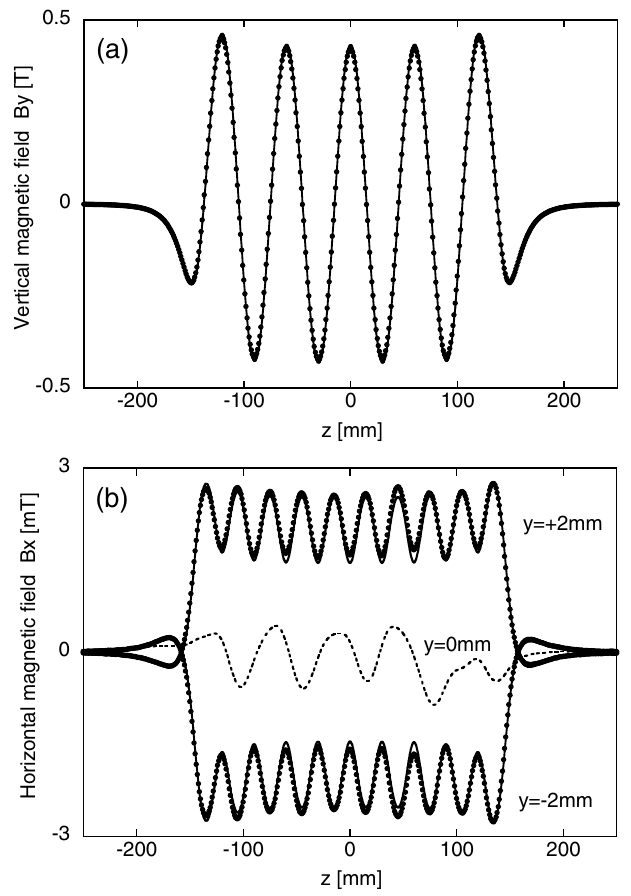
FIG. 5. Magnetic field of the EF wiggler at a magnet gap of 30 mm measured along the beam axis ( z axis): (a) the vertical magnetic field and (b) the horizontal magnetic field. The solid circles and the dotted line show measured values and the solid lines show calculated ones. The vertical magnetic field is mea- sured along the central axis of the wiggler at x ¼ y ¼ 0 mm , while the horizontal magnetic field is measured at three different transverse positions of x ¼ 0 and y ¼ 0 , (cid:4) 2 mm . The magnetic field at y ¼ 0 shown with the dotted line in panel (b) is the measured values, while the magnetic fields at y ¼ (cid:4) 2 mm are derived from the measured values at y ¼ (cid:4) 2 mm by subtracting the magnetic field at y ¼ 0